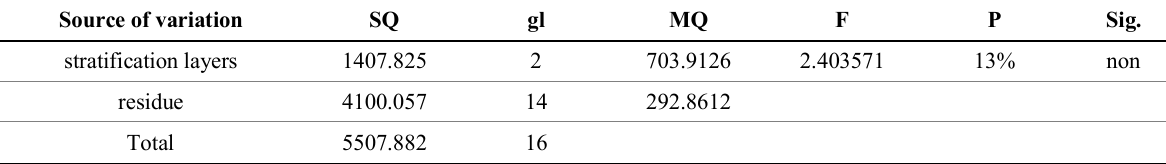
Table 3. Analysis of variance (ANOVA) - compressive strength of recycled concrete Source of variation SQ gl